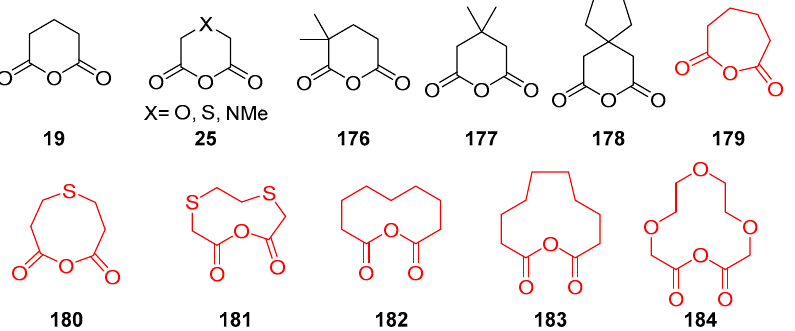
Figure 3. The 6 to 12-membered cyclic anhydrides used in the CCR. Cyclic anhydrides with more than six members are highlighted in red.